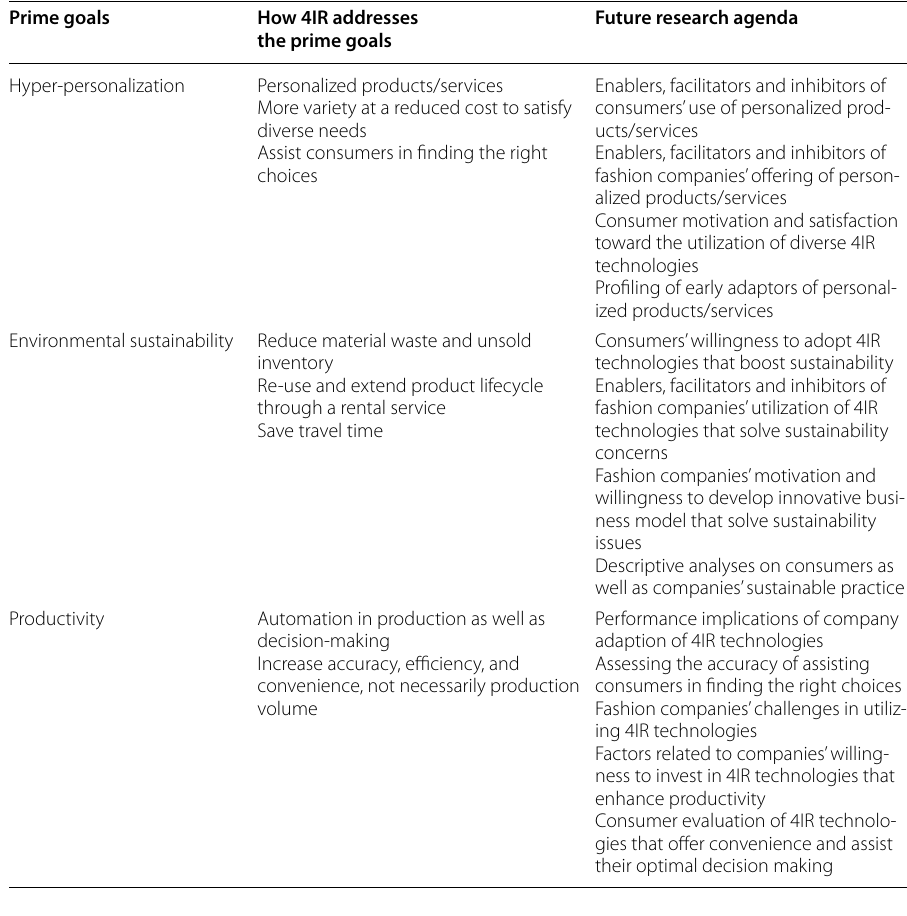
Future research agenda +